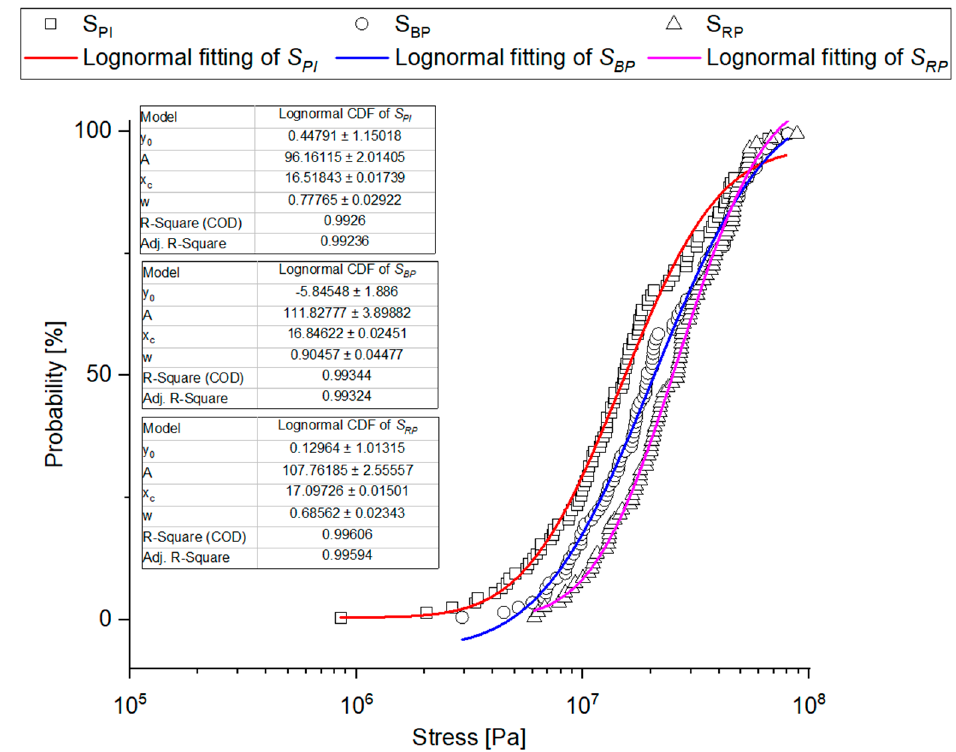
Figure 13. Probability plot distributions fitted to experimental values of stress.